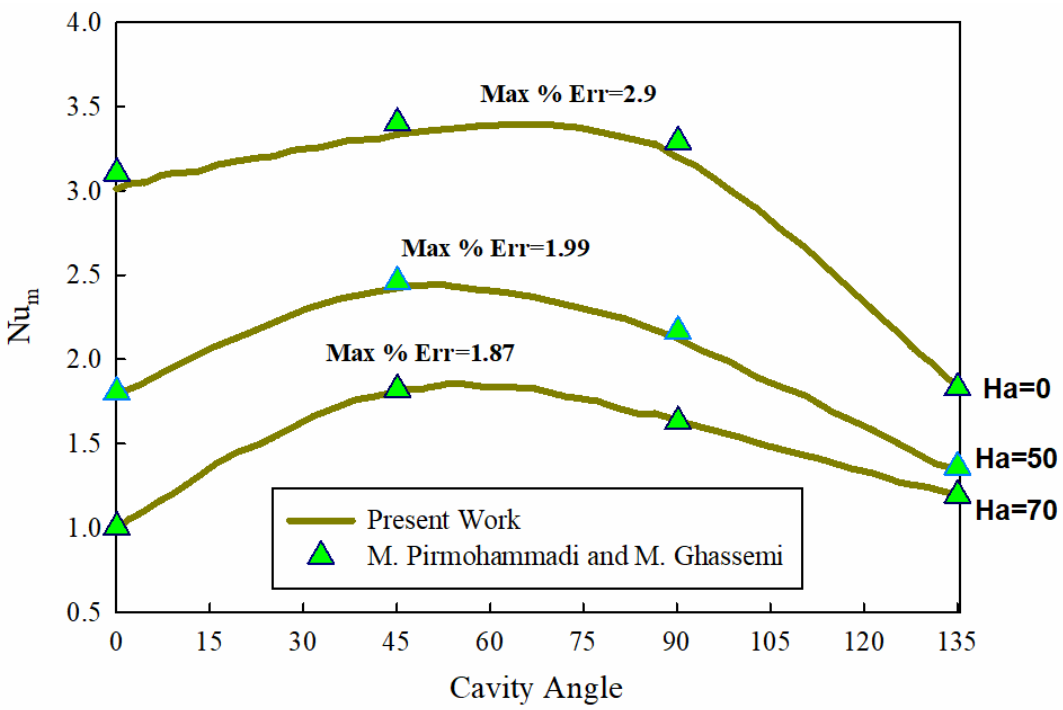
Figure A1. Average Nu versus cavity angle for different Ha.